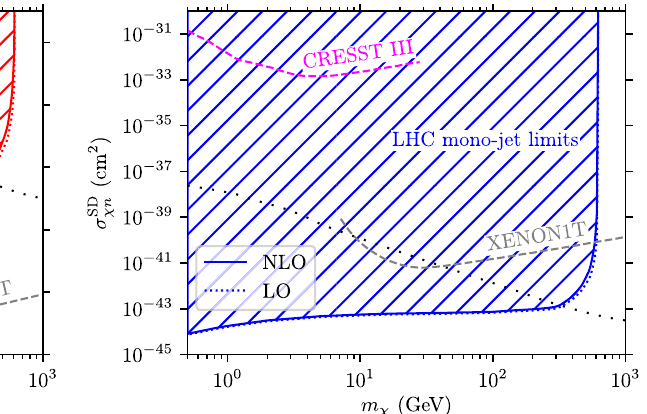
of Eq. (2), see text for details. Parameter points on the black dotted lines are compatible with the measured relic abundance, the areas above (below) correspond to an under-abundance